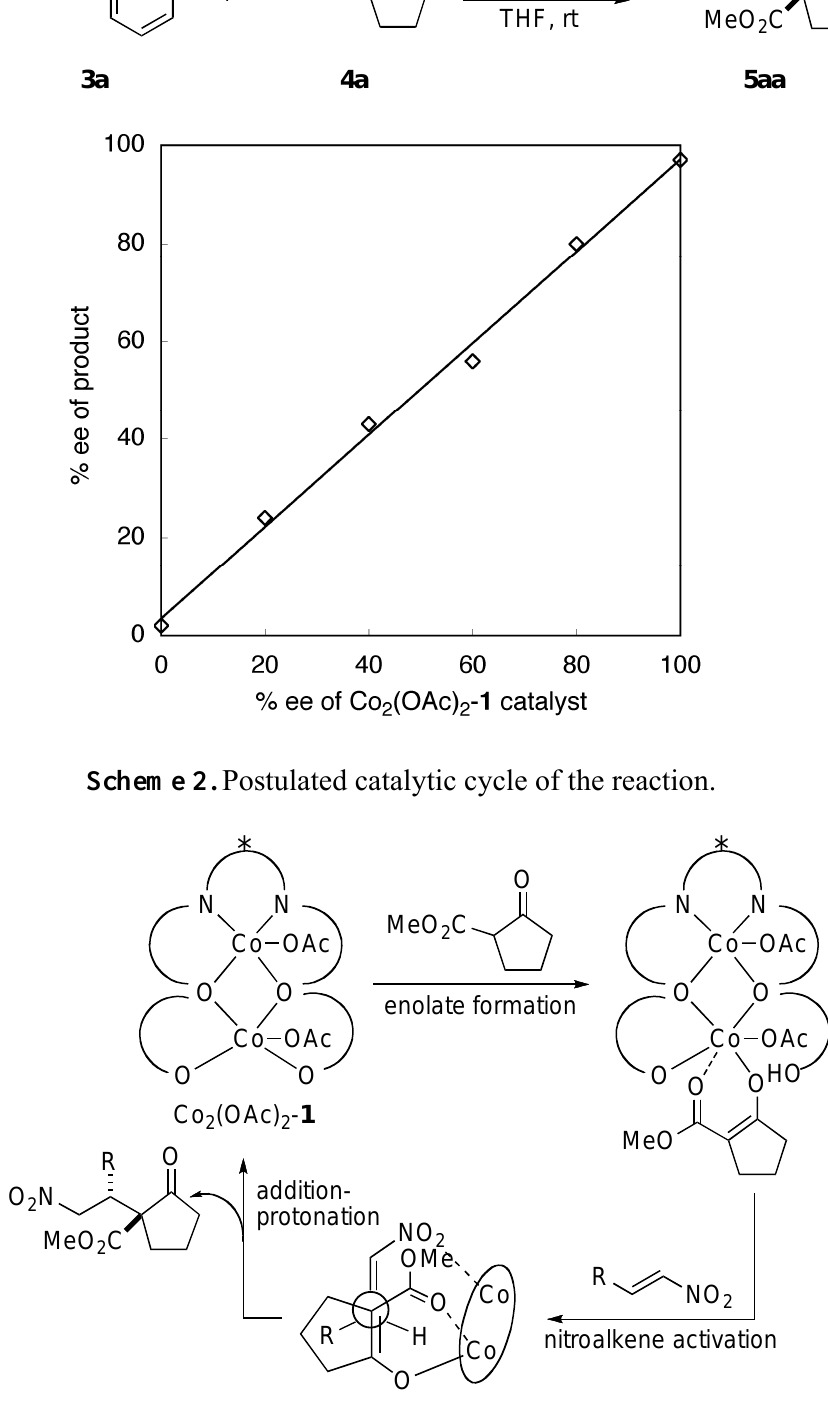
(OAc) - 1 catalyst and% ee of 2 2